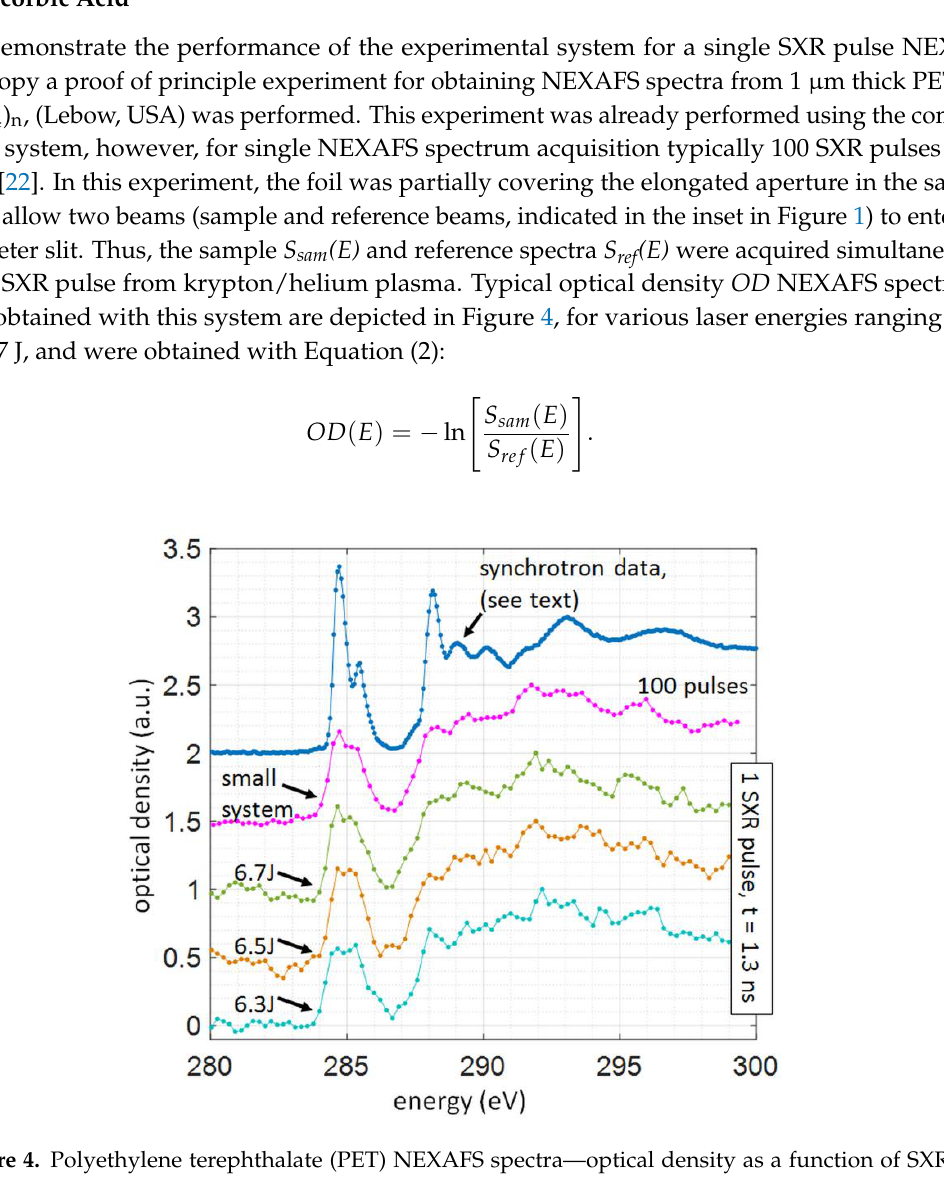
Table 1. Energy positions and assignments of features depicted in Figure 5, taken from [27], in the C- 1s NEXAFS spectrum of PET foil, based on synchrotron data.